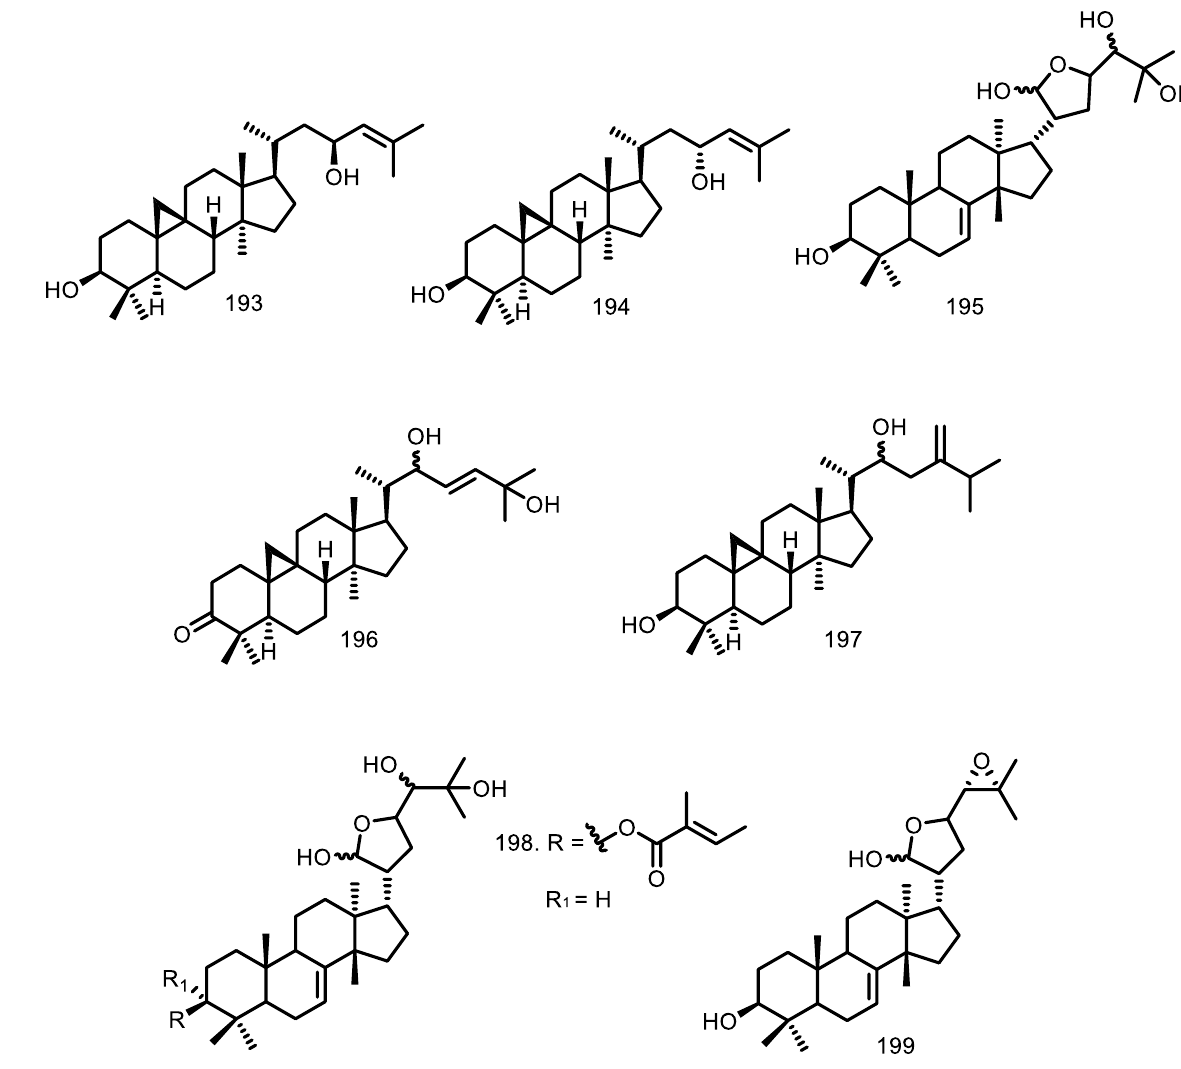
Figure 5. Triterpenoid from Guarea